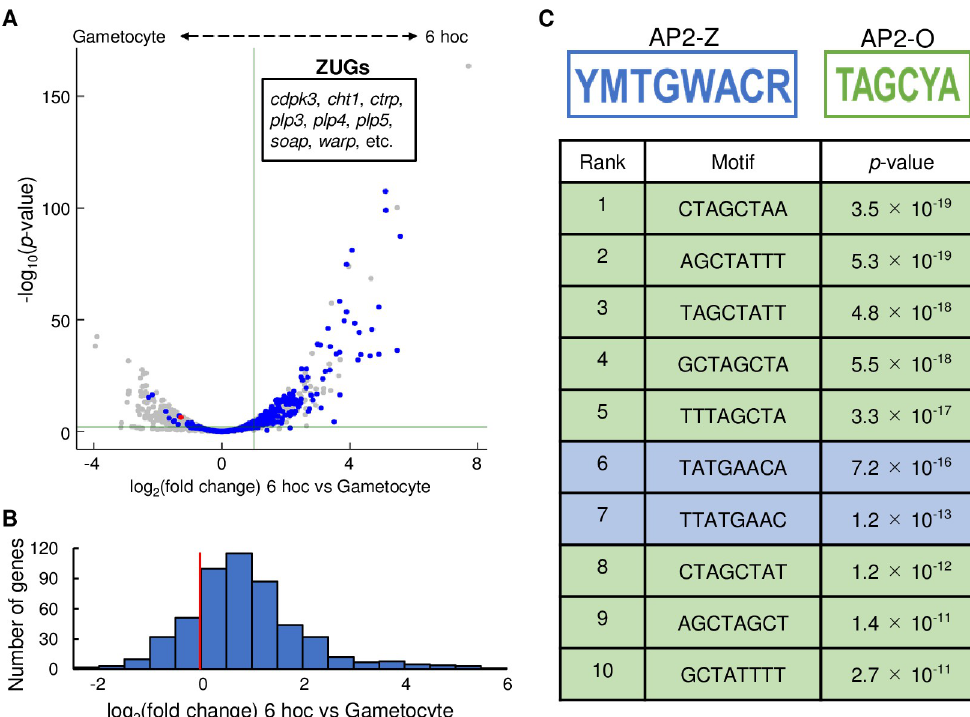
Fig 6. Differential expression analysis between gametocytes and zygotes at 6 hoc. (A) Volcano plot showing differential expression analysis between gametocytes and zygotes at 6 hoc. Red dot represents ap2-z and blue dots represent the target genes of AP2-Z. Green horizontal line indicates a p -value of 0.05 and a vertical line indicates a log 2 (fold change) of 1. (B) Histogram of the number of AP2-Z targets against the log 2 (fold change) value (bin = 0.5) in the differential expression analysis. Red vertical line indicates a log 2 (fold change) of 0. (C) Eight-base motifs enriched in the upstream of zygote- upregulated genes. AP2-Z motifs are indicated in blue and AP2-O motifs are indicated in green. Motifs were ranked according to their p